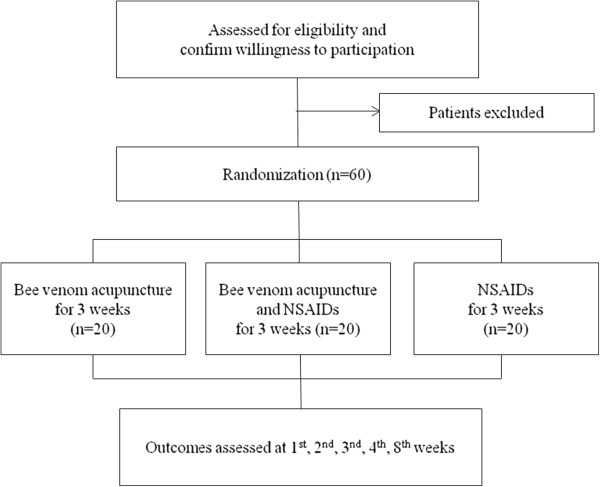
Study flowchart.